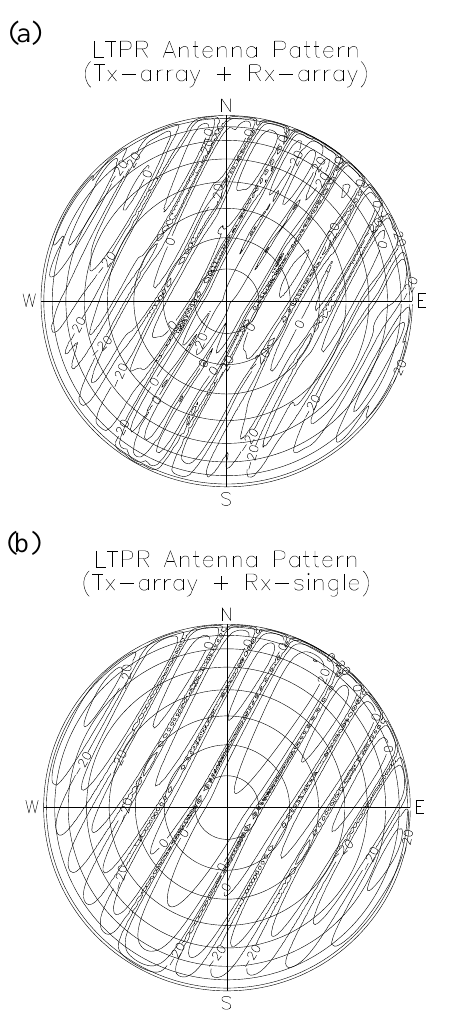
Fig. 3. Two-way antenna patterns for the LTPR, (a) where the Rx array is used for receiving, (b) where a single antenna is used for receiving. Concentric circles indicate zenith angles with a 10deg interval.